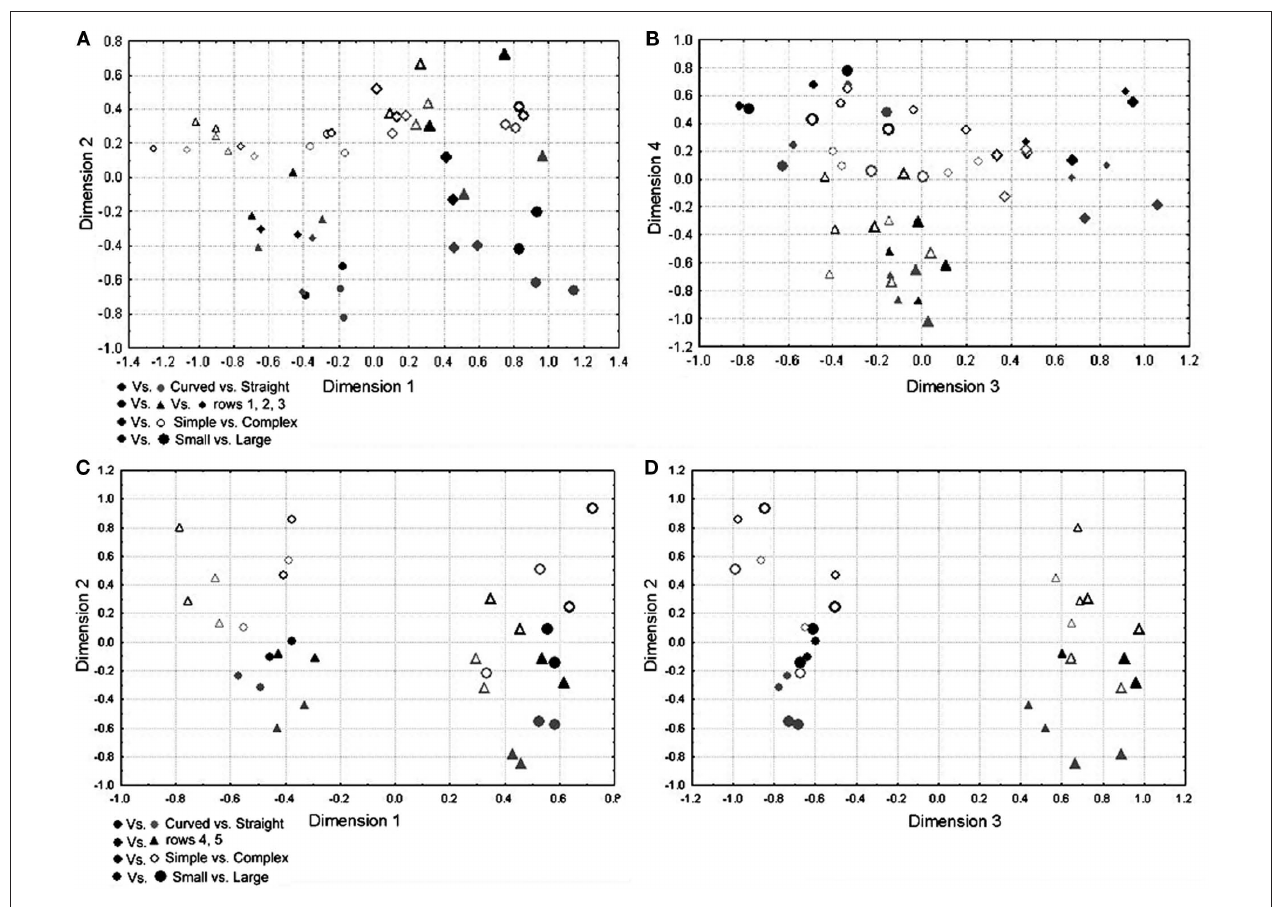
Figure 7 | representations of the MDS-solutions for the subsets of shapes used in experiment 2. Curved shapes are presented in black, straight shapes in gray; simple shapes are denoted by filled symbols, complex shapes by open symbols; larger shapes are presented by larger symbols; the row of the